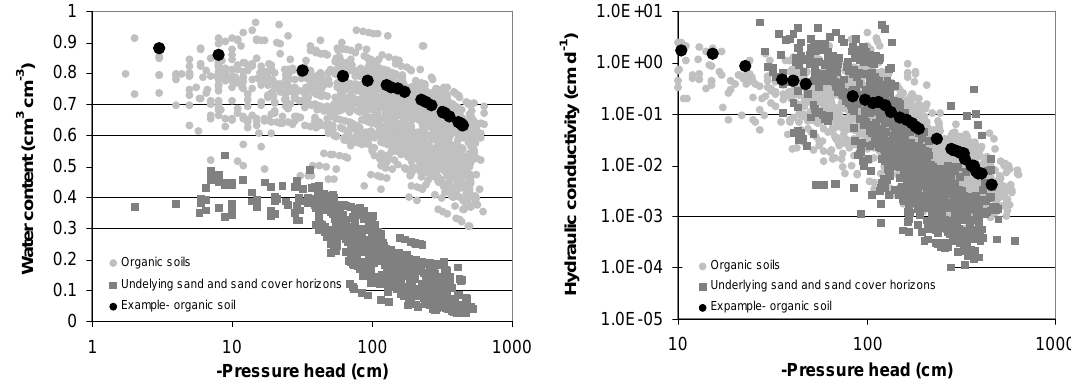
Figure 2. Data range of organic soils, underlying sand and sand cover horizons, and a pair of measured hydraulic functions. time interval, ∆ V is the total water volume evaporated from the complete sample (equal to sample mass di ff erence, ∆ m